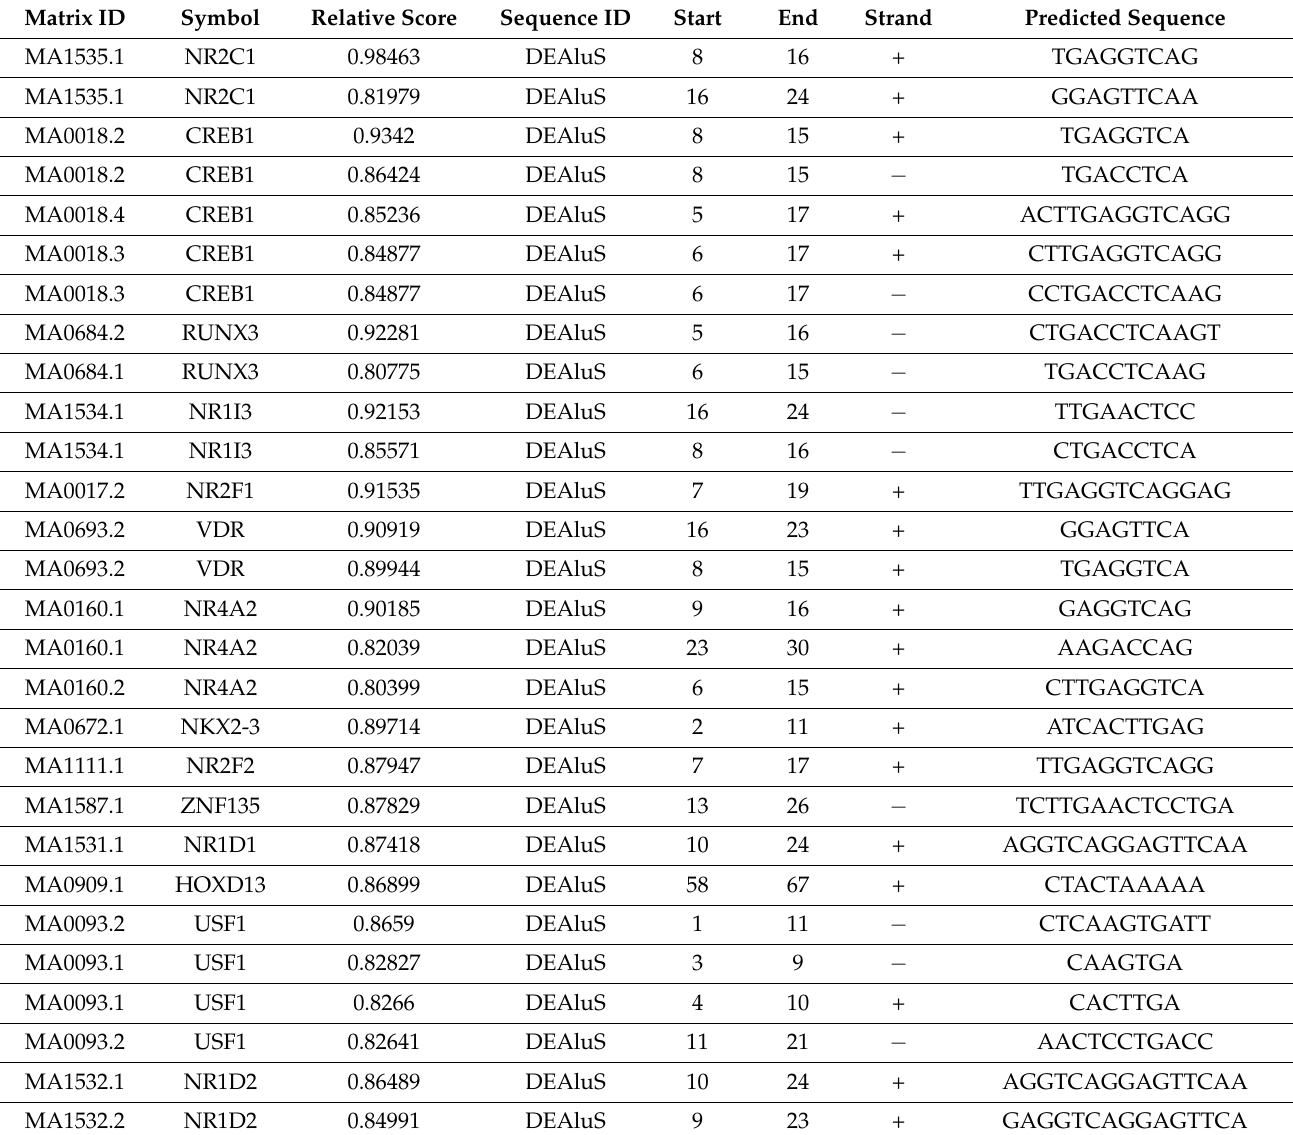
Table 3. List of unique ASD-associated TFs binding at the DE-AluS consensus sequence predicted by JASPAR CORE database. “+” represents the sense strand and “–“ represents the antisense